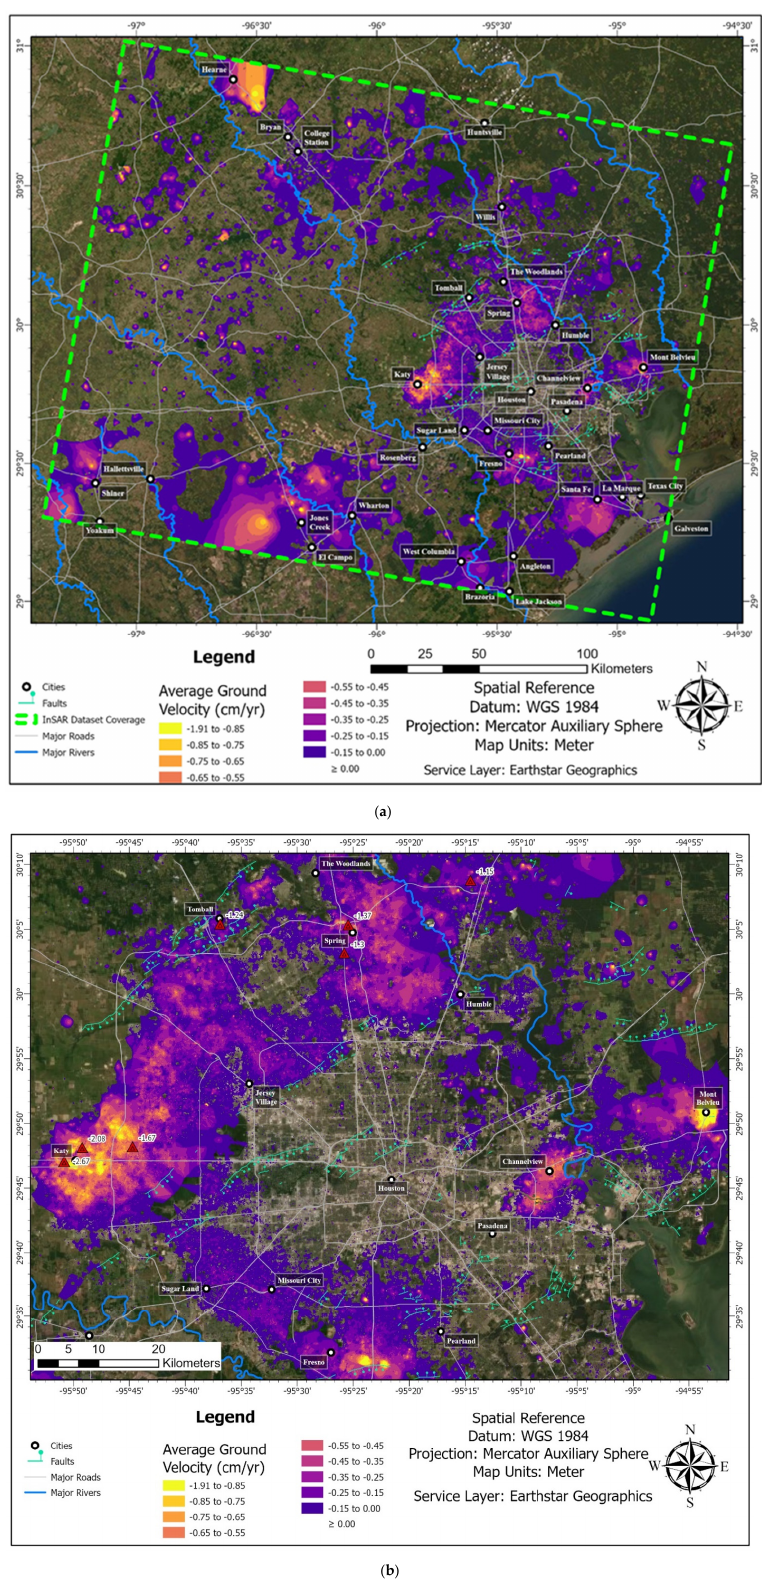
Figure 3. ( a ) Average ground velocity per year from March 2016 to December 2020 measured by SBAS, InSAR data for Houston and surrounding areas. View of the entire InSAR footprint. ( b ) Zoomed-in view showing downtown Houston and encompassing suburbs and towns. Red triangles indicate the locations of GNSS stations In the Tomball area northwest of Houston, GNSS station P017 shows vertical dis- placement rates of − 1.24 cm/yr from 2000 to 2021 and − 0.6 cm/yr from 2016 to 2020. The subsidence rate derived from the InSAR displacement product for that area ranges from − 0.65 to − 0.85 cm/yr. The GNSS station P047, located north of Houston in the Spring area, was installed in 2007 and shows a subsidence rate of − 1.37 cm/yr from 2007 to 2021. The InSAR results of this same region yield similar rates, ranging from − 0.75 cm/yr to − 1.9 cm/yr. Comparatively, very little differences between the InSAR and GNSS results can be observed.